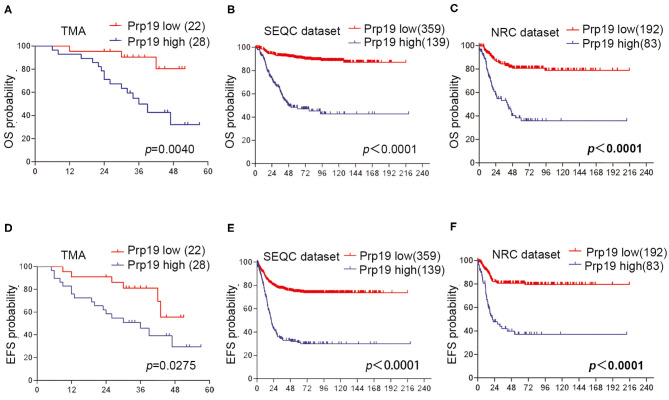
Prp19's prognostic value in TMA cohort and data sets. (A,D) Kaplan-Meier analysis of OS and EFS for the TMA cohort based on Prp19 expression with the log-rank test P-value indicated (n = 50). (B,E) Kaplan-Meier analysis of OS and EFS for the SEQC data set based on Prp19 expression with the log-rank test p value indicated (n = 498). (C,F) Kaplan-Meier analysis of OS and EFS for the NRC data set based on Prp19 expression with the log-rank test p-value indicated (n = 275).